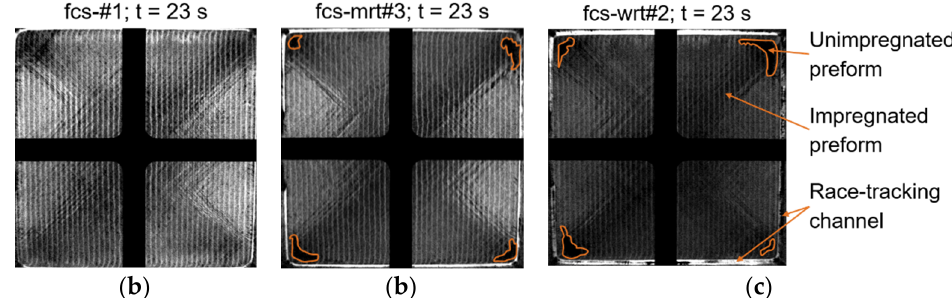
Figure 13. Preform impregnation on the bottom side of the three experimental scenarios of the flow control study at 23 s: ( a ) complete filling of experiment without a race-tracking channel fcs-#1; unimpregnated corner sections of experiments with a medium fcs-mrt#3 ( b ) and wide fcs-wrt#2 ( c ) race-tracking channel.